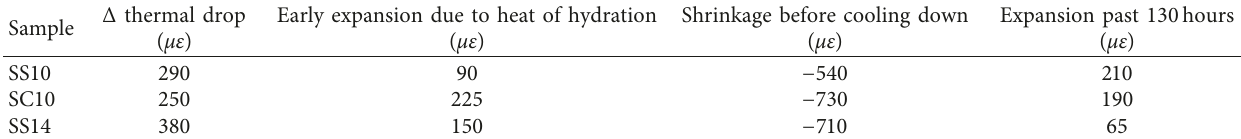
Table 3: Comparative deformation values.